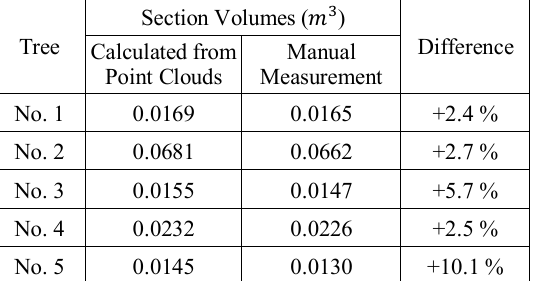
Table 3. Stem volumes of selected trees